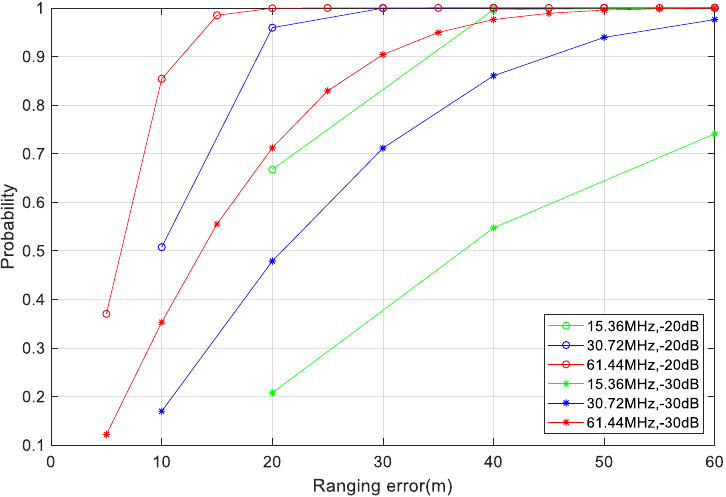
Figure 9. Probability of ranging error within different distances.